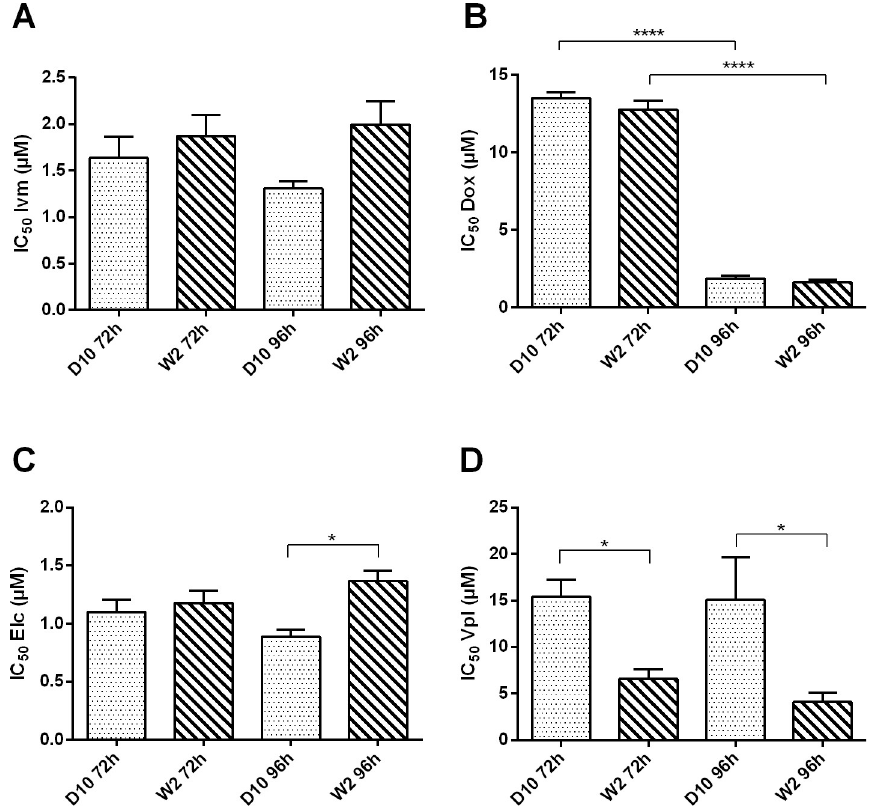
Fig 1. Graphs showing the IC 50 ± Standard Error of each drug alone on P . falciparum chloroquine-sensitive (D10) or chloroquine-resistant (W2) strains at 72h or 96h time length bioassays. (A) Ivermectin (Ivm); (B) Doxycycline (Dox); (C) Elacridar (Elc); (D) Verapamil (Vpl). � represents a statistically significative difference between the IC 50 values ( � p < 0.05; �� p < 0.01; ���� p < 0.0001).